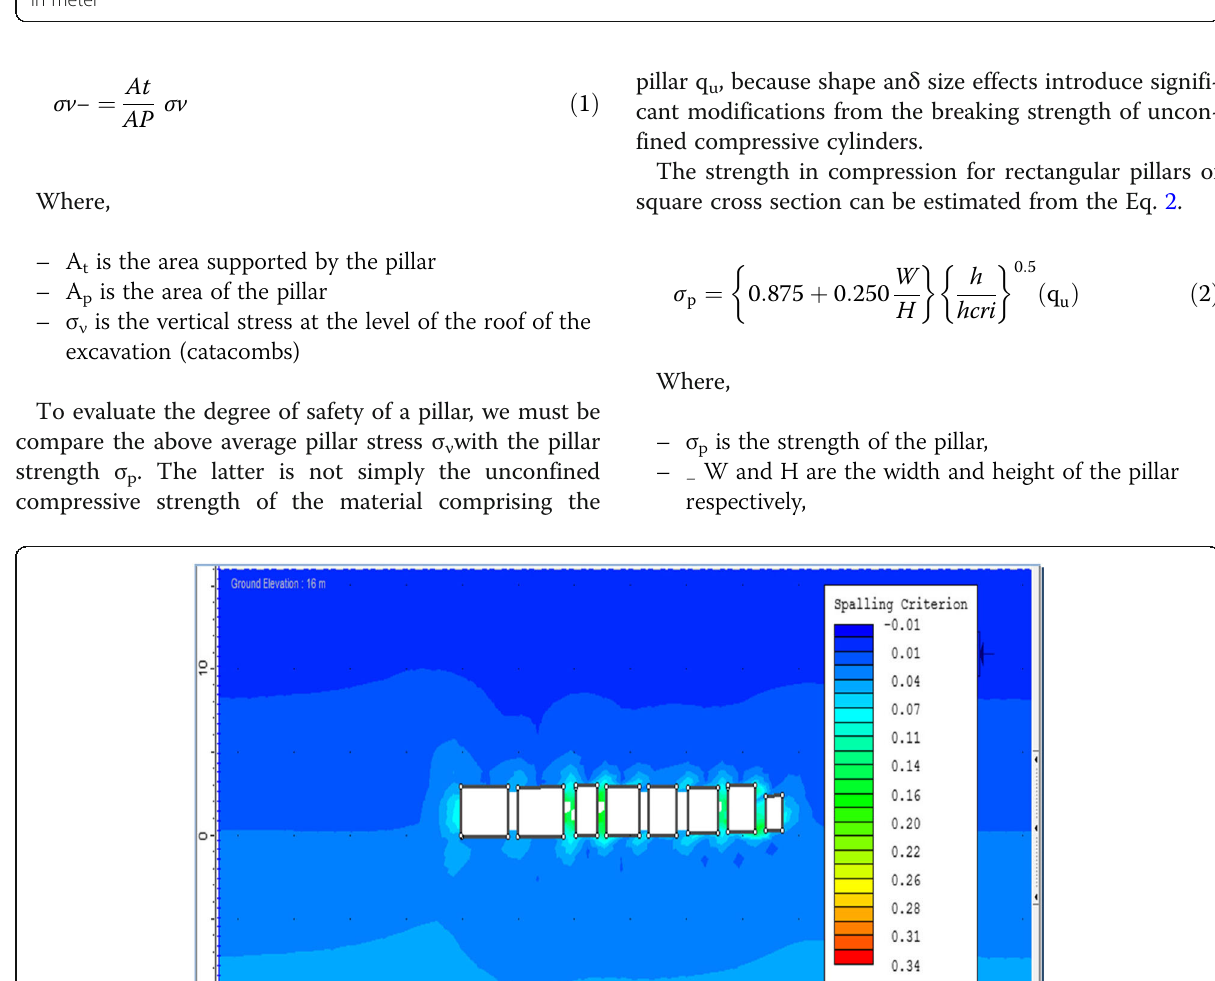
Fig. 13 Effective vertical stresses distribution through the rock pillars in Chamber 3. Examine 2D. All units of distance and depth in all figures are in meter